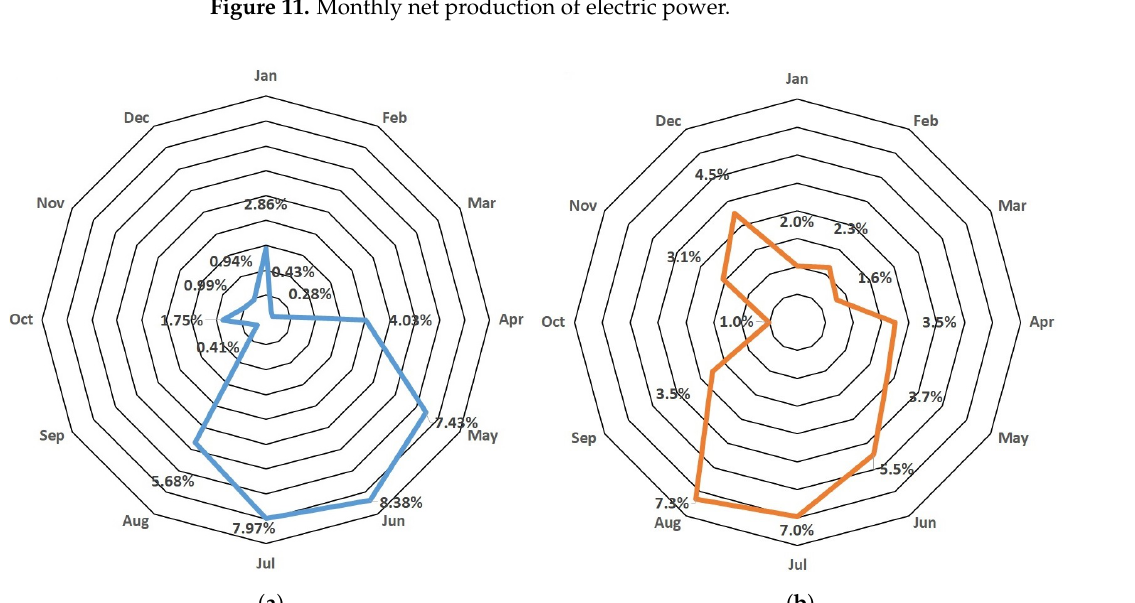
Figure 12. Monthly variability of the percentage relative error. ( a ) Site 1 case. ( b ) Site 2